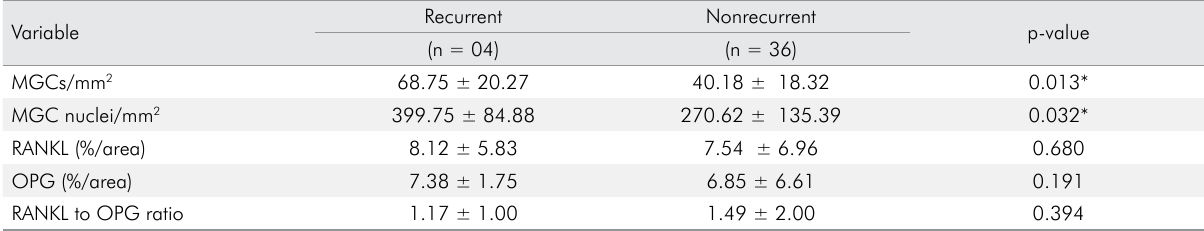
Table 2. Comparison of multinucleated giant cells and immunoexpression of nuclear factor kappa-B ligand and osteoprotegerin in central and peripheral giant cell lesions according to